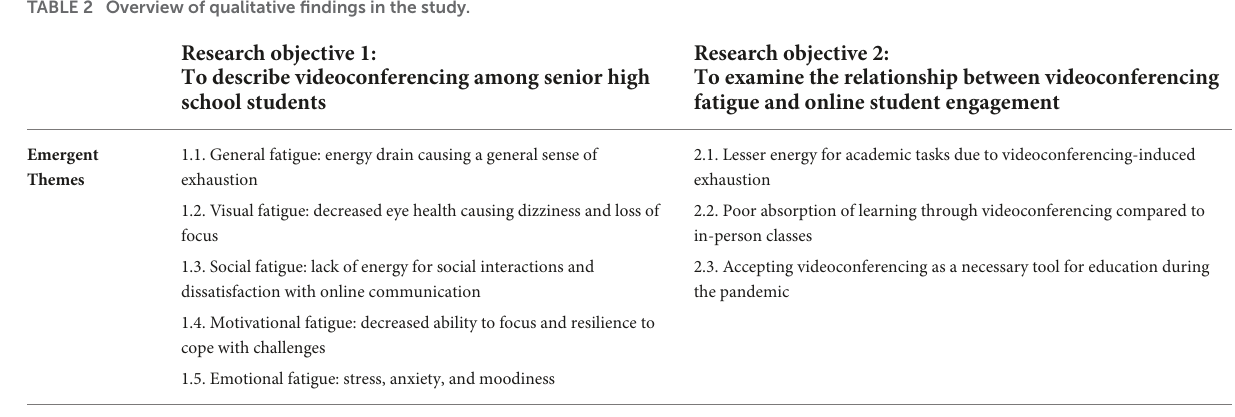
TABLE 2 Overview of qualitative findings in the